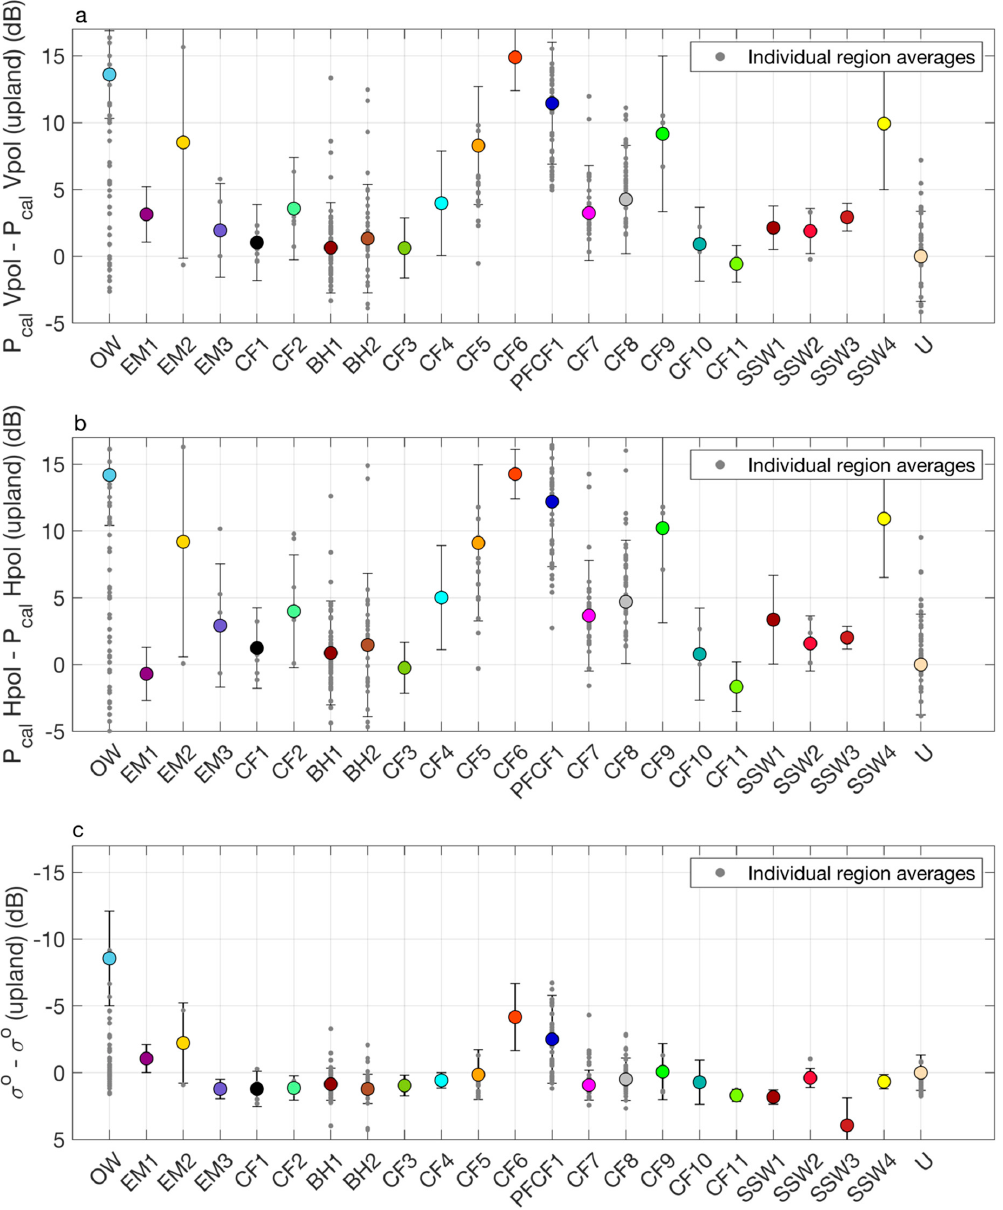
Figure 8. ( a ) Mean GNSS-R P cal Vpol observation, binned by the landcover classes in the Caddo Lake area, defined in Table 1. Error bars are ± one standard deviation. Observations are relative to the mean value over uplands (U), which was 156.63 dB. ( b ) Same as ( a ) except for GNSS-R P cal Hpol observations (mean value over uplands = 158.39 dB). ( c ) Same as ( a ) except for sigma nought observations from Sentinel-1. The mean value over uplands (U) was -10.4 dB. Individual region averages are shown by the grey dots.